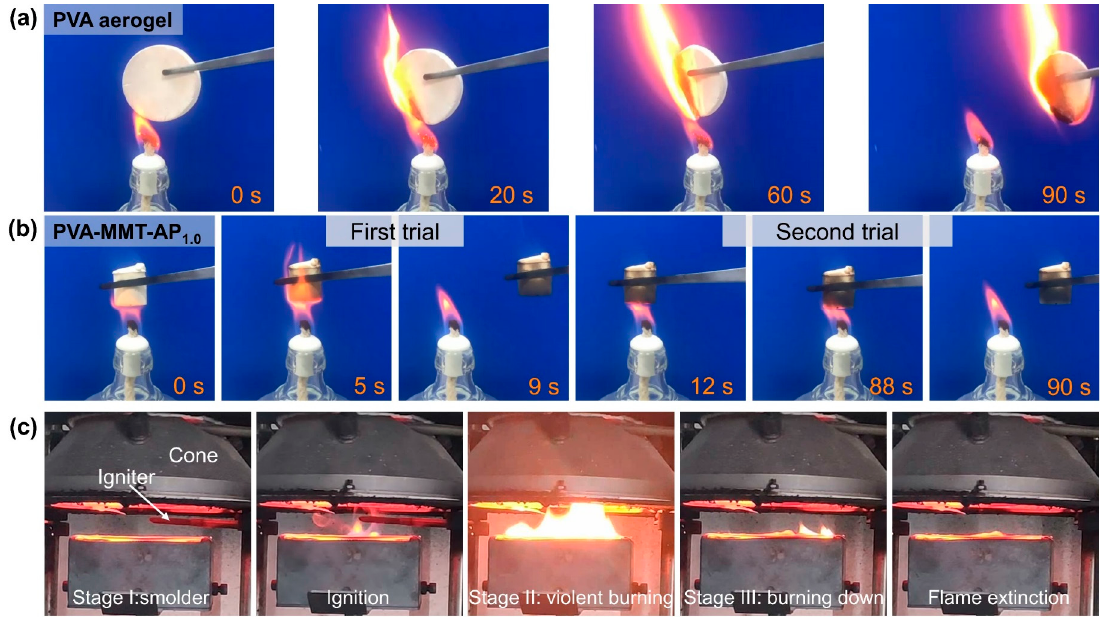
Figure 7. The combustion behavior of ( a ) the PVA aerogel and ( b ) PVA-MMT-AP 1.0 under an alcohol lamp. ( c ) The combustion process of the PVA-MMT-AP 1.0 under a heat flux of 50 kW/m 2 .